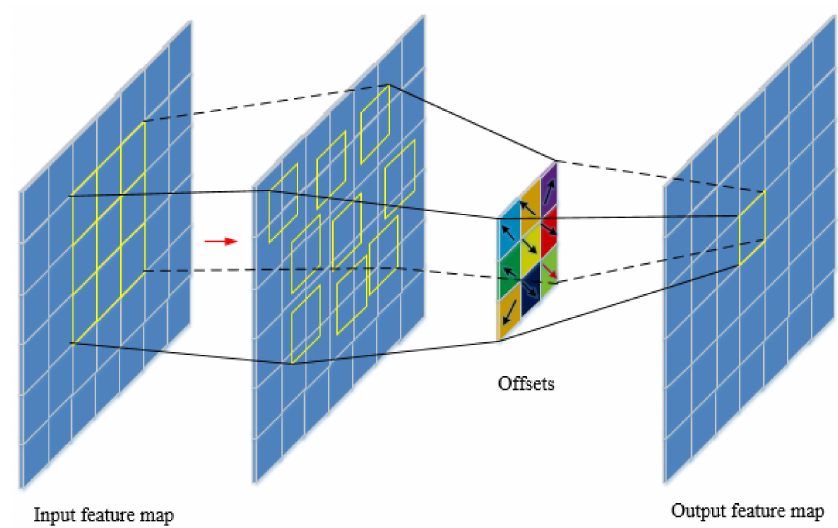
Figure 14. Schematic diagram of the deformable regions of interest (ROI)